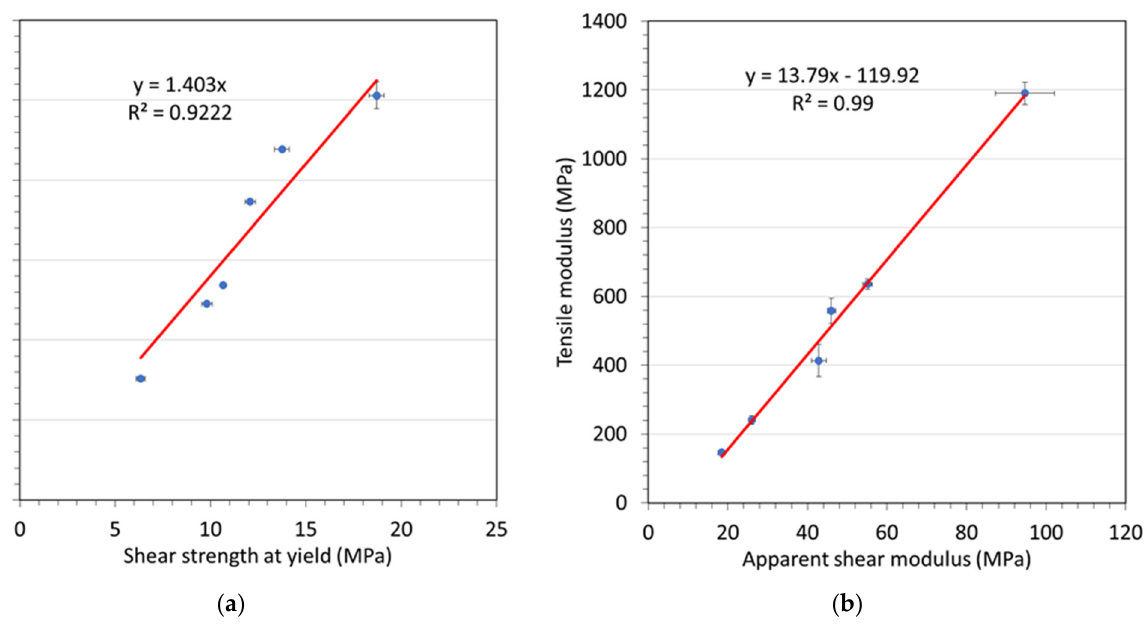
Figure 5. Scatter plots of ( a ) tensile yield strength versus shear strength at yield, and ( b ) tensile modulus versus apparent shear modulus, obtained from tensile and punch-shear testing, for coupons made of Polymer A2.